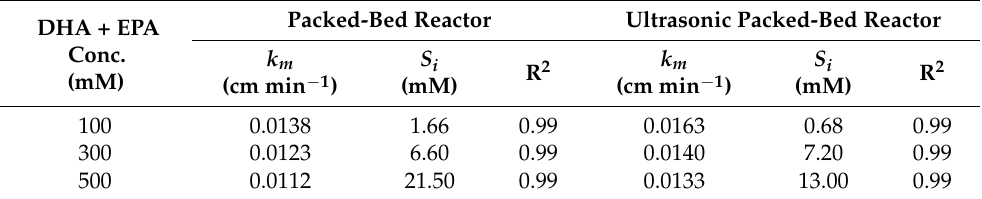
Figure 4. The mass transfer limited model of ● packed-bed bioreactor and ○ ultrasonic packed-bed bioreactor operated at a DHA + EPA concentration of 500 mM and different flow rates. Table 3. km and Si obtained from Equation (5) for packed-bed bioreactor and ultrasonic packed-bed bioreactor operated at a different substrate concentration.